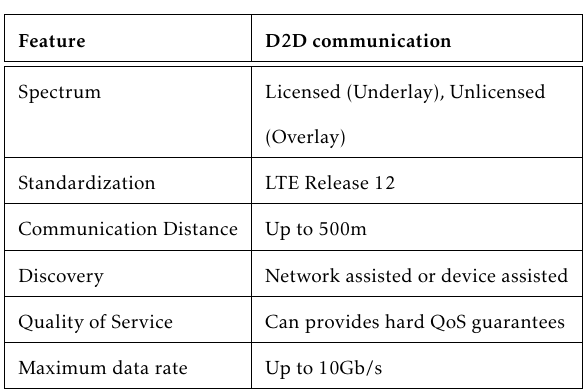
Table 3. Basic features of D2D